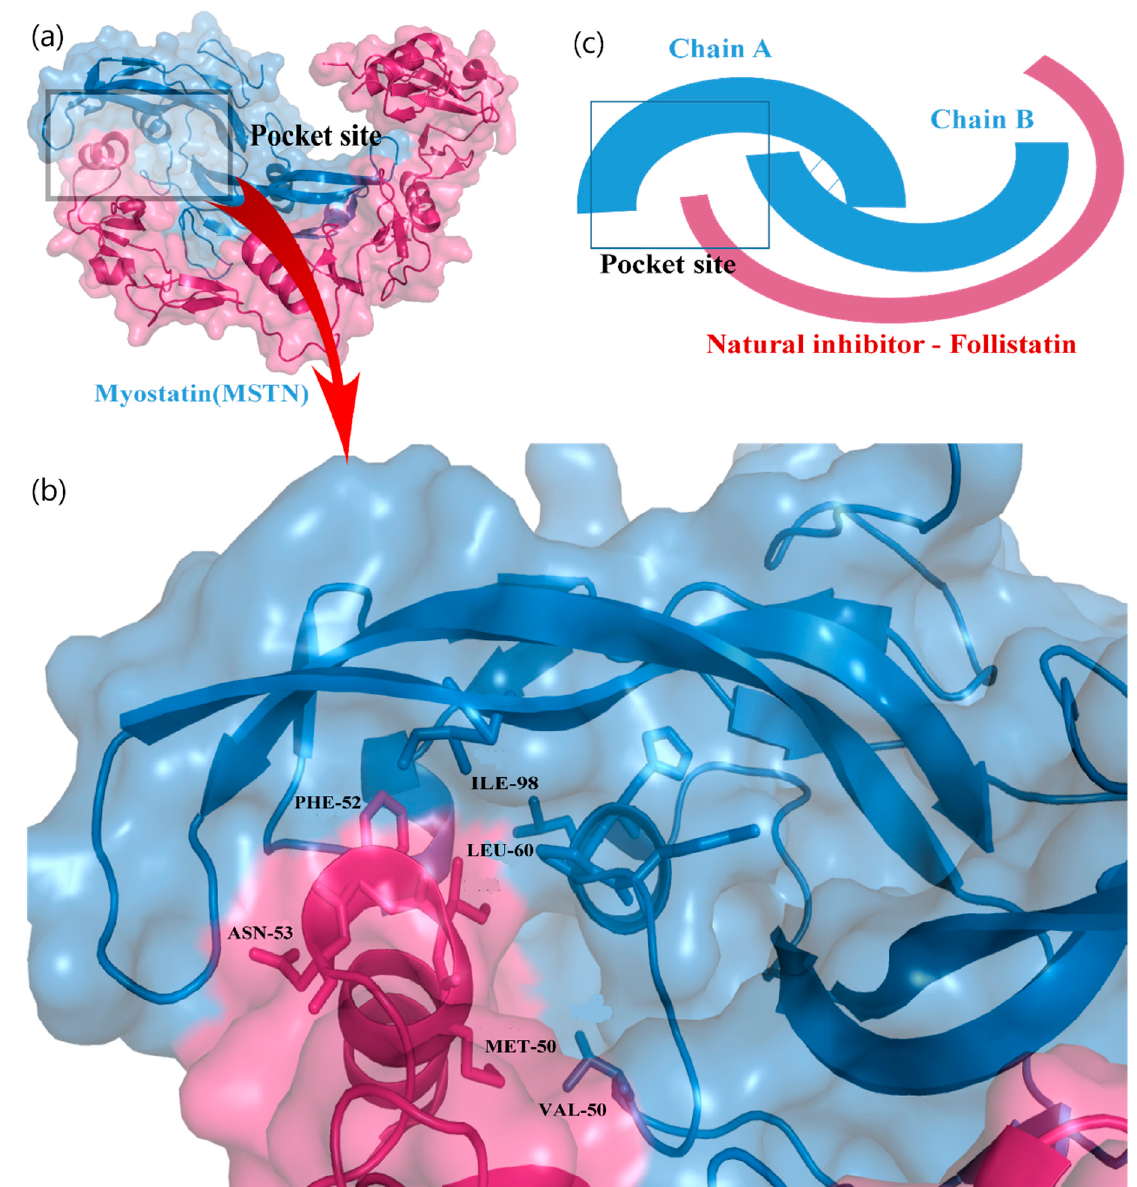
Figure 1. Identification of active site of MSTN protein. ( a ) MSTN-follistatin288 complex structure, ( b ) enlarge view of helix-helix interaction with MSTN. ( c ) Cartoon model of active pocket of MSTN protein.